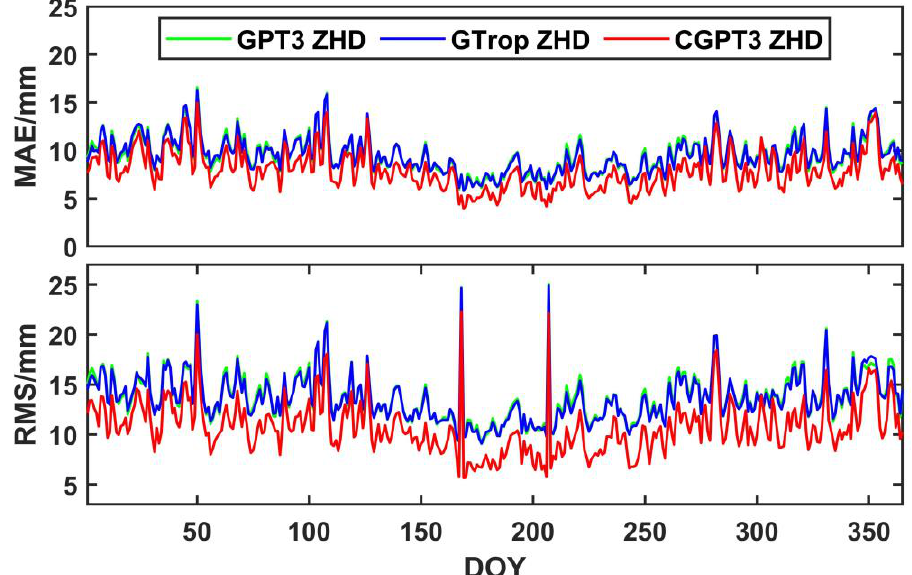
Figure 7. Daily average MAE and RMS variation of ZHD derived from the three models.